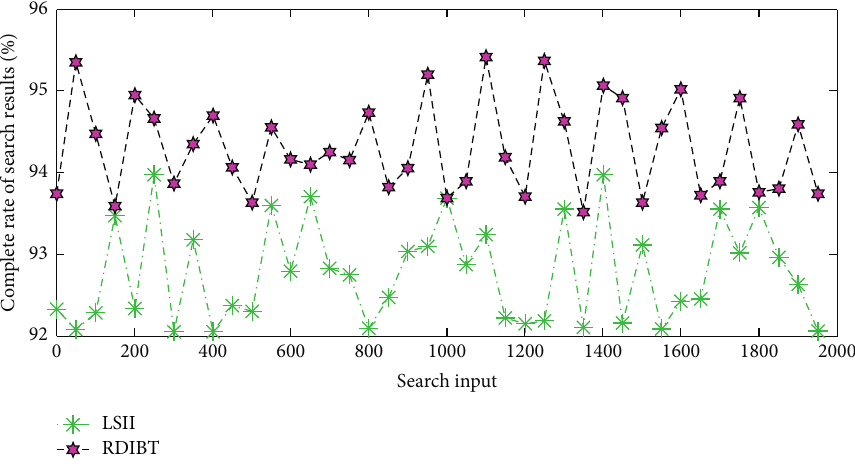
Figure 9: The completeness rate of RDIBT and LSII search results.